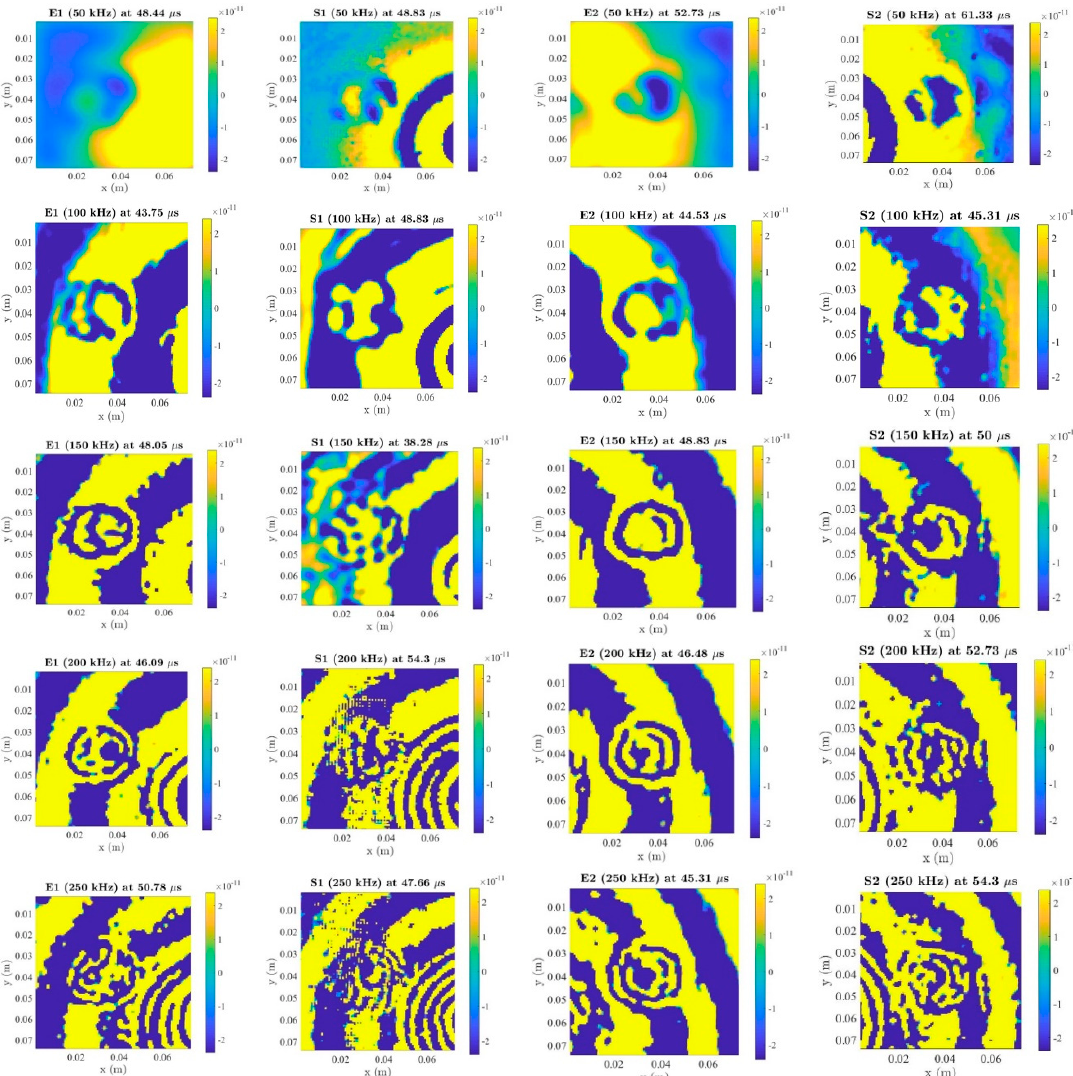
Figure 17. LDV results for impact damage (E: embedded, S: surface ‐ mounted).